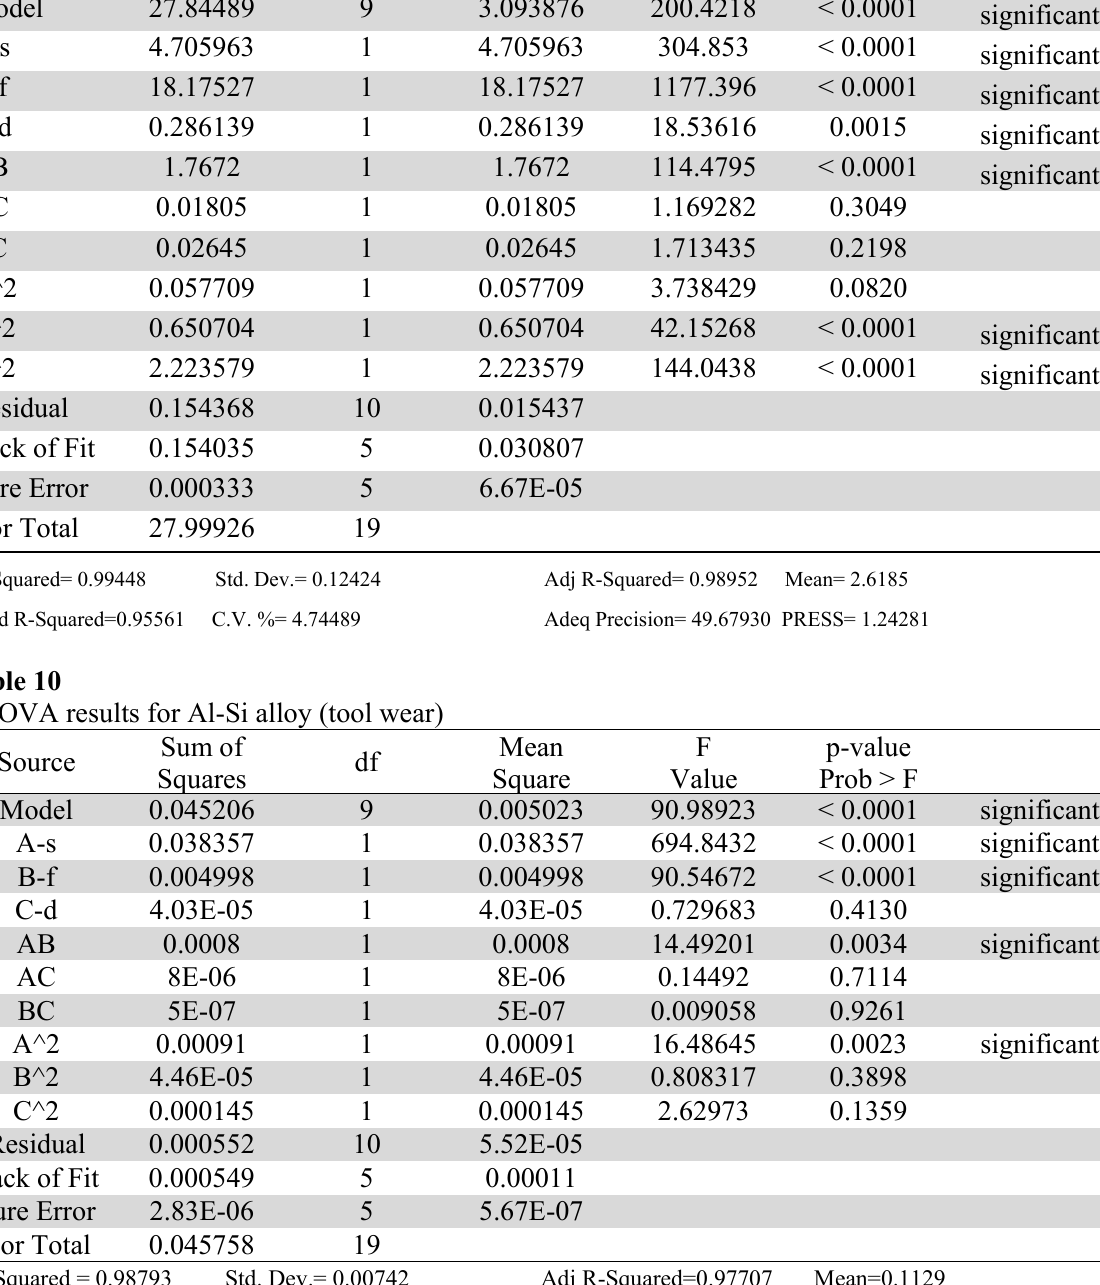
ANOVA results for Aluminum alloy matrix composite (surface roughness) Source